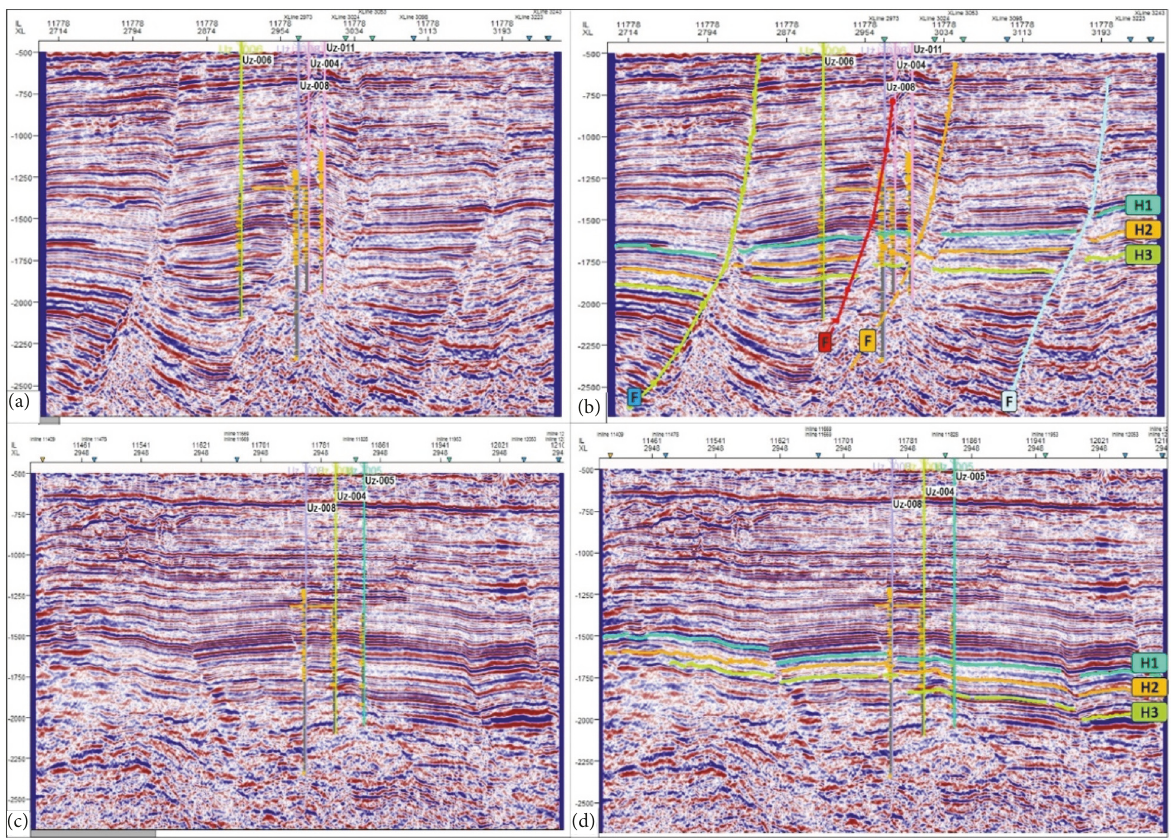
Figure 4: (a) Un-interpreted seismic section (inline) with wellbore showing near vertical point of discontinuity. (b) Interpreted seismic section of Figure 1(a), showing picked faults and mapped horizons. (c) Uninterpreted seismic section (crossline) with wellbore showing high amplitude continuous reflections. (d) Interpreted seismic section of Figure 1(c), showing mapped horizons (H1/D3100, H2/D5000, and